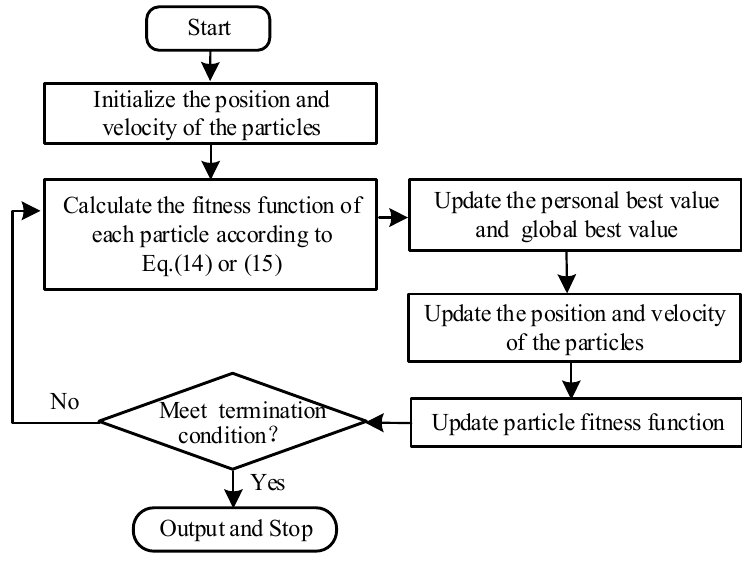
Figure 4. Flowchart of the PSO.